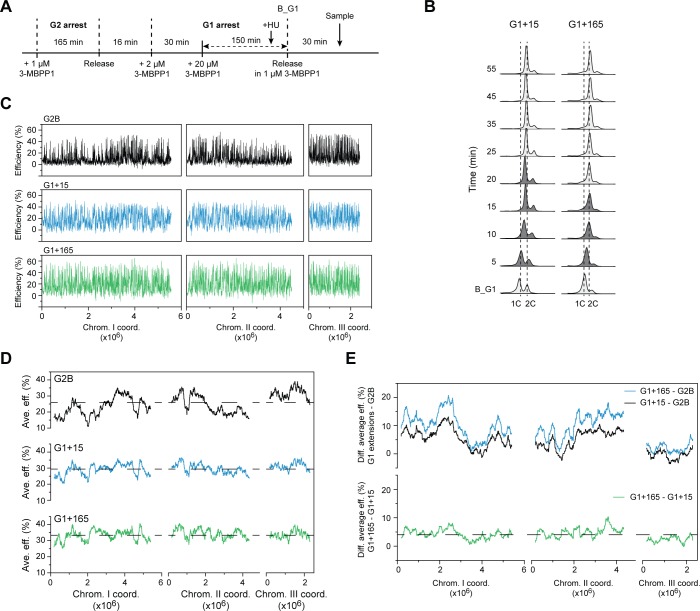
Limits of reprogramming DNA replication by temporal regulation of CDK activity.A) Experimental design for determining the replication profile in Cdc13-Cdc2 cells with a long delay in CDK availability (G1+165). For array experiments, HU was added to the cells 10 min before the release from the 20 μM 3-MBPP1 inhibitor treatment (B_G1). Cells were harvested 30 min following this release, after S phase is completed in a sample without HU (see B). B_G1: G1 block. B) DNA content analysis of G1+15 and G1+165 cells undergoing a synchronous S phase. The data for G1+15 are as in Fig 2B. The experimental procedure for G1+165 was as in A, but without HU treatment. Samples in which cells are undergoing DNA replication are shown in dark gray. B_G1 indicates the end of the prolonged G1. In the G1+165 conditions, cells have fully divided by the time of the release (B_G1), resulting in one major 1C peak. The ensuing S phase leads to a rightward shift of this peak to 2C. See Materials and Methods for additional details for the interpretation of flow cytometry profiles. C) Origin usage profiles of G2B, G1+15, and G1+165. Data for G2B and G1+15 are as in Fig 2C. x-axis: chromosome coordinates, y-axis: origin efficiencies. For full detailed profiles and one-to-one comparisons of origin efficiencies, see S4A and S4B Fig, respectively. D) Regional profiles of replication domains in G2B (black), G1+15 (blue), and G1+165 (green). The averages of origin efficiencies were determined for continuous windows of ~250 kb (1000 probes). Data for G2B and G1+15 are as in Fig 2F. Dashed lines indicate the average efficiencies of all the origins in each program (G2B: 24.9%; G1+15: 29.4%; G1+165: 33.4%). x-axis: chromosome coordinates, y-axis: average origin efficiencies. E) Regional analysis of the changes in origin efficiencies. Top panel: Differences of the average origin efficiencies (blue: G1+165 - G2B; black: G1+15 - G2B) determined in continuous windows of 1000 probes (~250 kb). Bottom panel: Differences of the average origin efficiencies (green: G1+165 - G1+15) determined in continuous windows of 1000 probes (~250 kb). The dashed line marks the average difference in origin efficiencies between the G1+165 and G1+15 conditions (4%). x-axis: chromosome coordinates, y-axis: difference in average origin efficiencies. The higher efficiencies in G1+165 are likely to be due to the higher CDK activity level in this condition (see Fig 5).